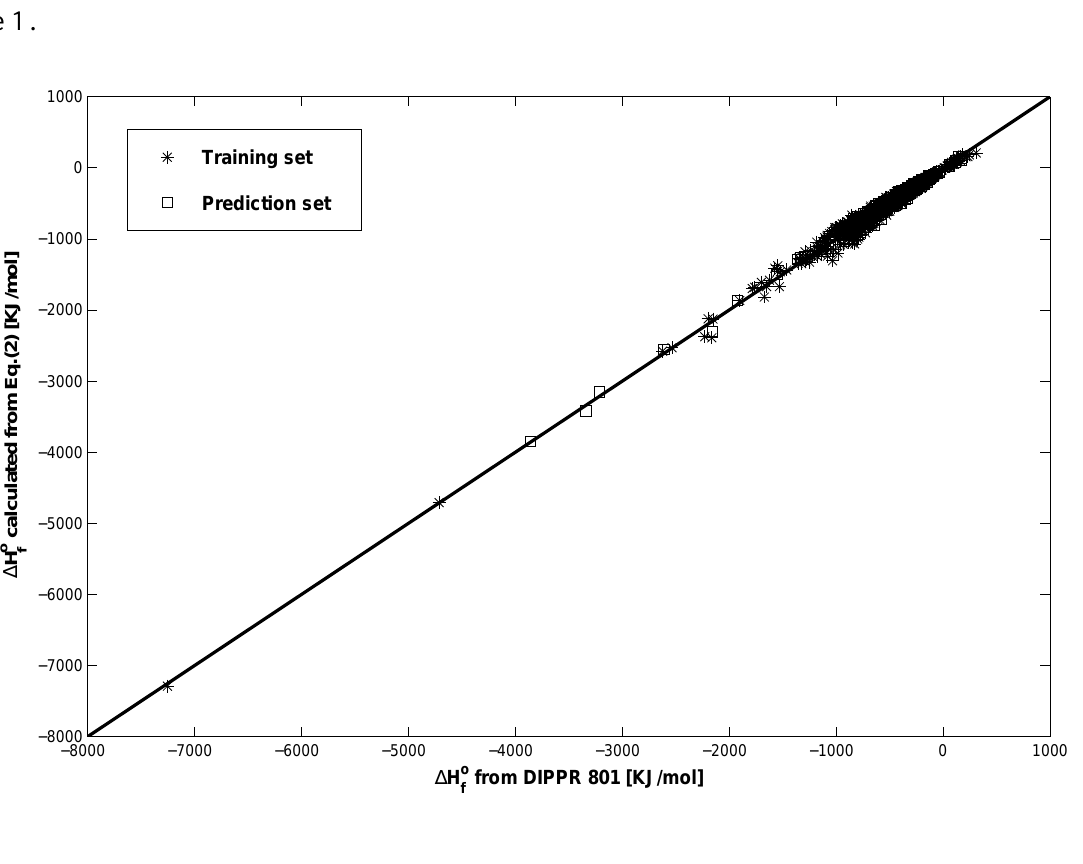
Figure 1. Comparison between the results of Eq. (2) for training set and predicted values for training